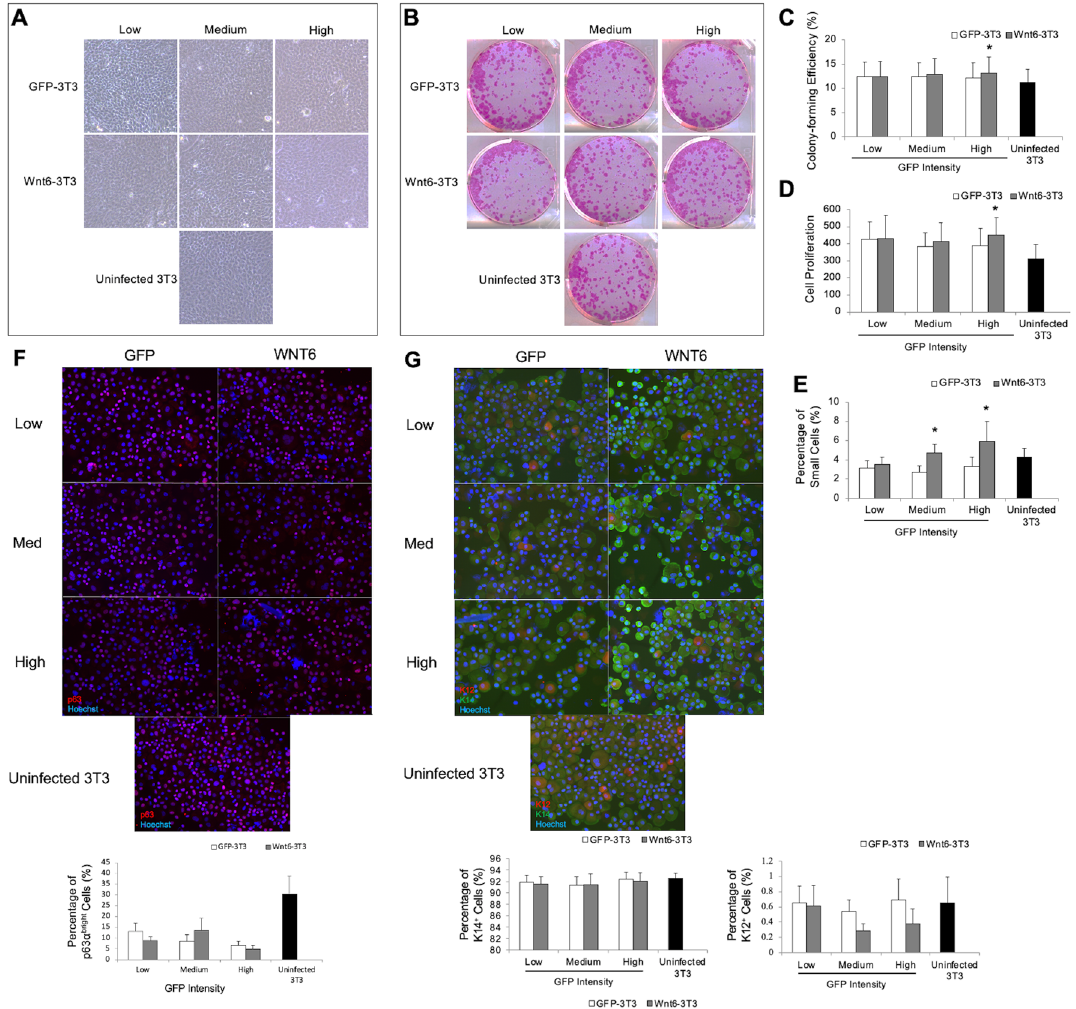
Figure 3. Cellular characteristics of LSCs cultured on 3T3 cells overexpressing Wnt6. LSCs were cultured on GFP-3T3, Wnt6-3T3, and uninfected 3T3 cells for 10–14 days. ( A ) Morphology of LSCs was comparable under all conditions. ( B ) CFEs of cultured LSCs were comparable. ( C ) Quantitation of CFE percentages. ( D ) Quantitation of cell proliferation. ( E ) Proportions of small cells with diameters ≤ 12 mm, ( F ) Immunostainings of p63 cells in the different groups and proportions of p63α bright cells, ( G ) Immunostainings of K12 and K14 cells in the different groups and proportions of undifferentiated K14 + cells and differentiated cells determined by expression of K12. * P ≤ 0.05 in comparison with the corresponding GFP-3T3 controls. Data are means ± SEM of 4 the phosphorylation level of β-catenin by 1.75-, 2.30-, and 3.36-fold, respectively. This change in the level of phosphorylation was detected immediately upon Wnt6 exposure, confirming activation of β-catenin (Fig. 4B). Wnt6 regulates the non‑canonical pathway. Just as β-catenin is associated with the membrane and is associated with the canonical pathway, RhoA is present at adherent junctions in cellular membranes and is asso- ciated with the non-canonical Wnt/planar cell polarity (PCP) pathway 42,43 . Figure 4C shows that the total RhoA levels generally decreased over time with all treatments of Wnt6 CM. However, analysis of phosphorylated RhoA at the serine 188 site (phospho-RhoA S188 ), which negatively regulates RhoA 38 , showed an immediate decrease in phospho-RhoA S188 levels upon treatment with medium- and high-Wnt6 CM by 54.18% and 76.70%, respectively (Fig. 4D). This suggests that RhoA activity was upregulated upon Wnt6 exposure. We also examined the expression of CamKII protein, which mediates the non-canonical Wnt/Ca 2+ pathway 44,45 . Upon Wnt6 exposure, CamKII expression increased immediately by 2.13-fold. Maximum levels were reached 30 or 60 min after treatment with Wnt6 CM in a dose dependent manner: a 3.37-fold increase was seen with low-Wnt6 CM treatment; a 3.88-fold increase, with medium-Wnt6 CM treatment; and a 5.33-fold increase, with high-Wnt6 CM treatment (Fig. 4E). Evaluation of phosphorylated CamKII levels, the activated form of the protein 45 , revealed the opposite trend in which low-Wnt6 CM treatment resulted in high phosphorylation levels, whereas medium-Wnt6 CM and high-Wnt6 CM resulted in 2.86- and 2.21-fold decreases, respectively